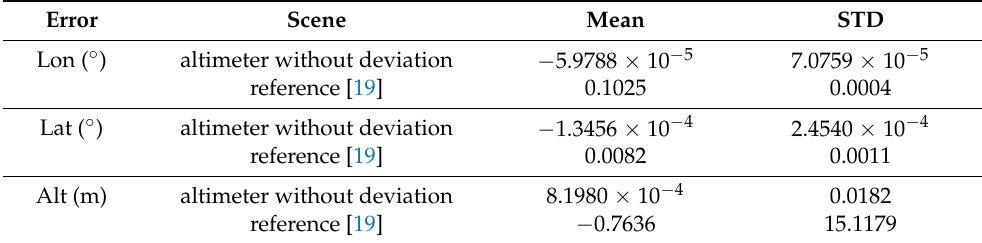
Table 12. Statistics of the